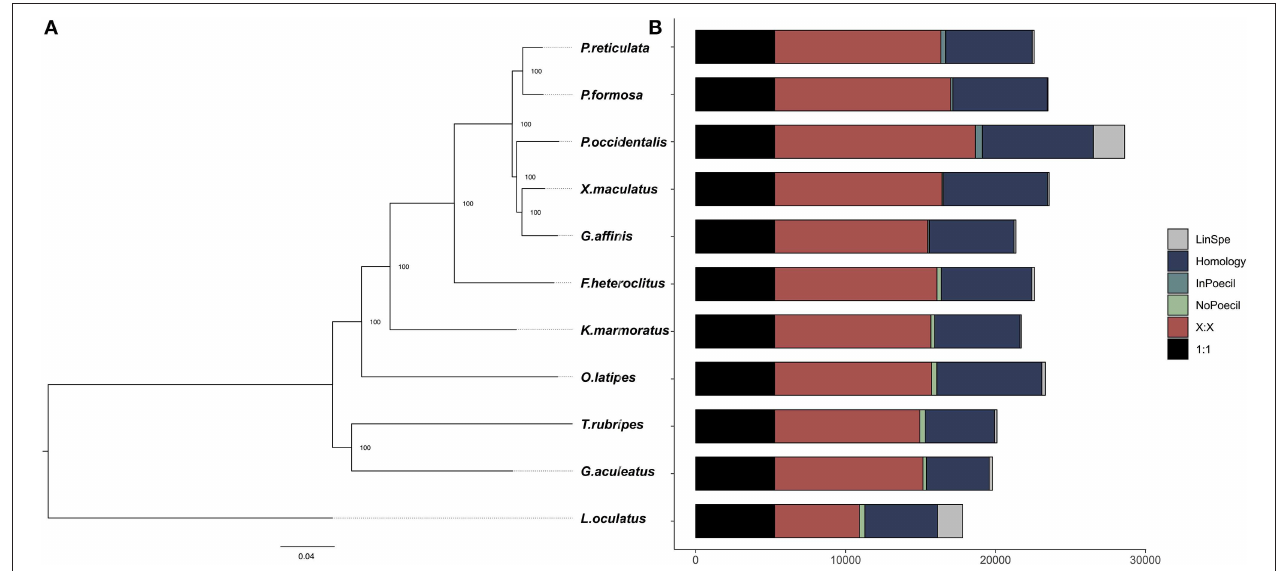
FIGURE 2 | Phylogenetic relationships and gene repertoire of P. occidentalis with other fish species. (A) A phylogenetic tree reconstructed using RaxML based on 5,276 one-to-one orthologs, the numbers on the nodes refer to the support value calculated from 100 bootstraps. (B) A bar chart revealing the percentage of orthologous genes of different types. “1:1” refers to universal single-copy genes; “X:X” orthologs exist in all species but not always as single copy; “NoPoecil,” orthologs exist in none of the Poeciliid branches ( Poecilia reticulata , Poecilia formosa , P. occidentalis , Xiphophorus maculatus, and Gambusia affinis ) but in at least two non-Poeciliid branches; “InTeleo,” orthologs exist in at least two Poeciliids but none of non-Poeciliid branches; “Homology,” orthologs exist in both Poeciliids and non-Poeciliids but are missing from at least one branch; “LinSpe,” lineage-specific genes where no ortholog was found in other branches.